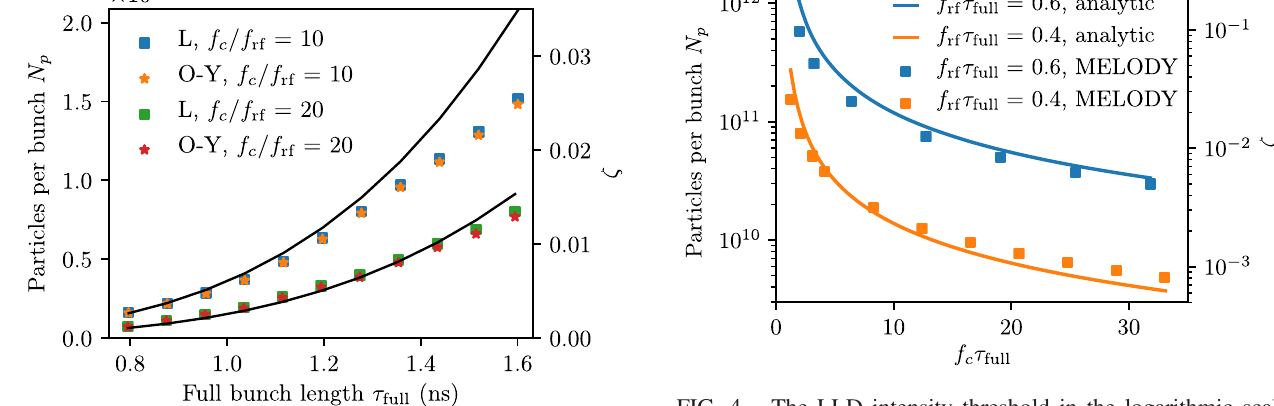
FIG. 3. The LLD intensity threshold as a function of the full bunch length τ calculated using the Lebedev equation (33) and full the Oide-Yokoya method (43) for different cutoff frequencies k f 0 ) of the inductive impedance. The analytic predic- ( f c ¼ max tions from Eq. (50) are shown by solid lines. The case of η > 0 and other parameters are Im Z=k ¼ 0 . 07 Ω , V 0 ¼ 6 MV, and μ ¼ 2 . The corresponding intensity parameter ζ is shown on the second vertical axis.